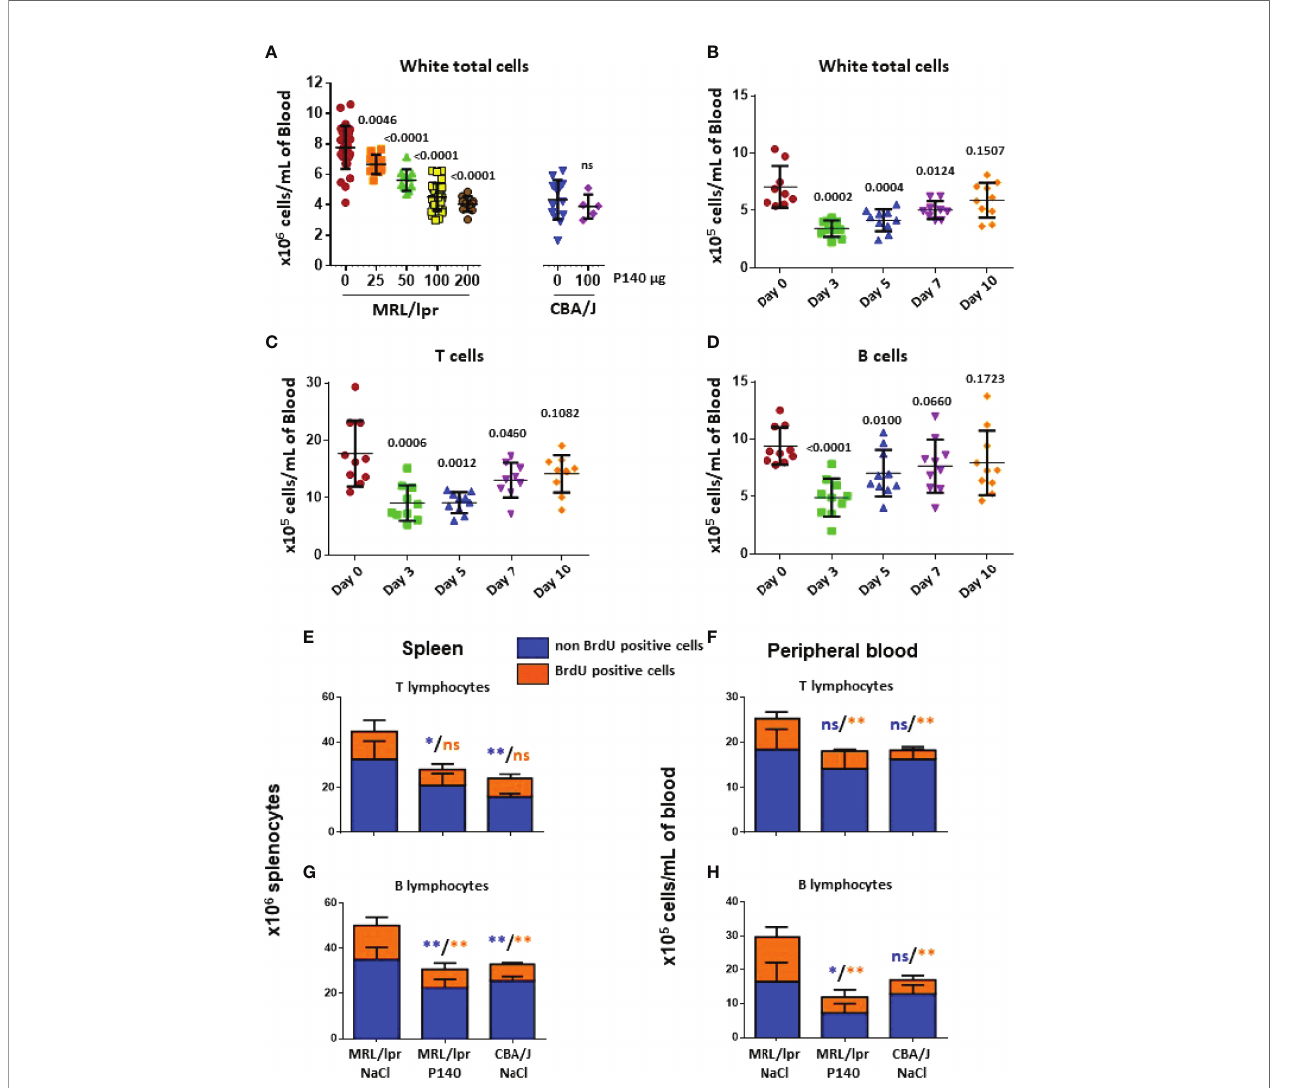
FIGURE 1 | In vivo effect of P140 peptide on the activity of immune cells in the spleen and peripheral blood of MRL/lpr mice. (A – D) . Reconstitution post-P140 treatment of the peripheral immune cell pool of normal and MRL/lpr lupus mice. 11-13 week-old female CBA/J or MRL/lpr mice received a single i.v. administration of either peptide P140 in saline (increasing doses in panel (A) ; fi xed dose of 100 µg peptide/mouse in panels (B – D) or saline only. The number of leukocytes/mL was evaluated by counting cells 5 days later panel (A) or sequentially until day 10 post-P140 treatment by fl ow cytometry after labelling cells with appropriate fl uorophores in panels (B – D) . Each symbol represents one individual mouse (n = 10-48 MRL/lpr mice and 5-14 CBA/J in panel (A) ; n = 10 in panels (B – D) . The results mixed from 2 independent experiments are presented. The horizontal bars represent the respective average cell count values. Statistical signi fi cance was assessed using unpaired t-test. Additional data are presented in the supplementary material. (E – H) . Long-term in vivo BrdU incorporation in various immune cell subsets of CBA/J and MRL/lpr mice that received or not P140 peptide. Age-matched mice received each a fi rst intraperitoneal injection of BrdU, which was then administrated in drinking water for 10 days. 10-11 week-old female MRL/lpr mice treated with P140 peptide were given a single i.v. dose of peptide 5 days after they received intraperitoneal injection of BrdU. Cells were collected from the spleen and PBMCs, stained by incubating them with fl uorescently-tagged antibodies to appropriate surface markers, fi xed stained with anti-BrdU antibodies, and analyzed by fl ow cytometry. Histograms represent the mean ± SD of BrdU + (cycling) or – (non-cycling) cells derived from 5 mice per group. Statistical signi fi cance was assessed using the Mann Whitney test. *p < 0.05; **p < 0.01; ns, non-signi fi cant. Additional data are presented in the supplementary